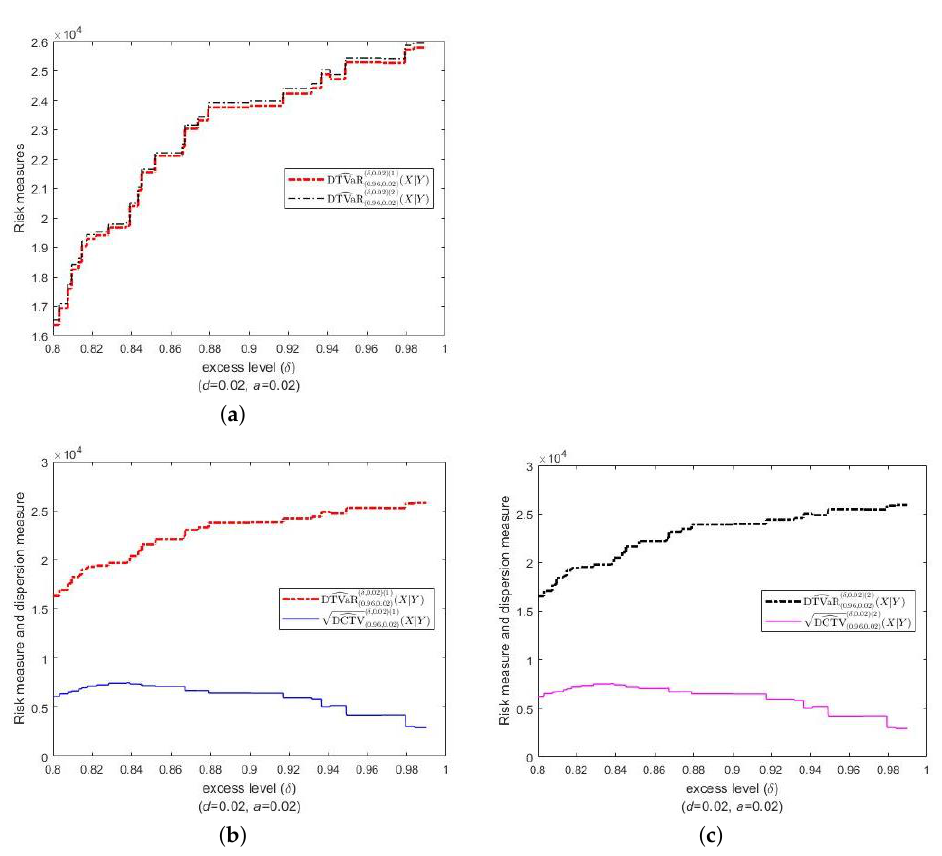
( δ , d )( n ) , n = 1,2, of claim value associated with vehicle value, ( α , a ) ( δ , d )( n ) for ( b ) n = 1 and ( c ) n = ( α , a )